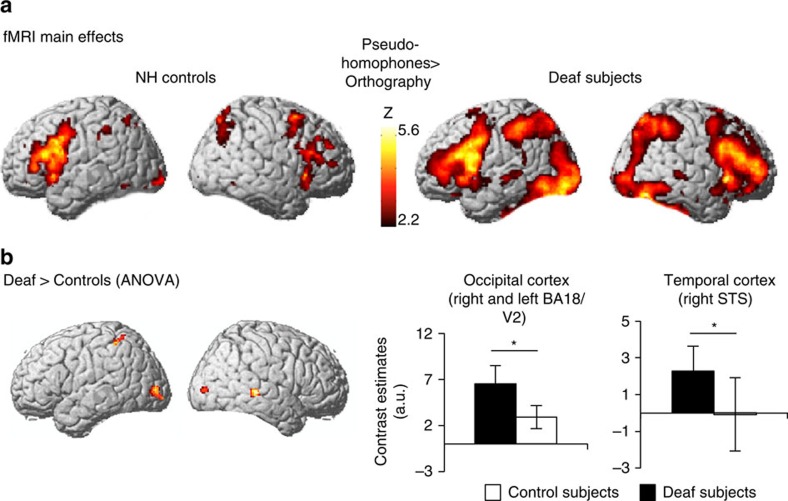
FMRI main effects.(a) Surface rendering of the main effects of phonological processing (P<0.05, FDR corrected for multiple comparisons) during the pseudo-homophone rhyming task in both groups (relative to the orthography control task). (b) Left: Surface rendering of the Deaf>Controls ANOVA results (P<0.05, FDR corrected for multiple comparisons). Right: parameter estimates in deaf subjects (black bars), and in normal hearing controls (white bars) in visual cortex (BA18/V2, left histogram, note that the pattern is similar in right and left visual cortex) and in the right posterior superior temporal sulcus (STS, right histogram). *indicates significant difference at P<0.05.